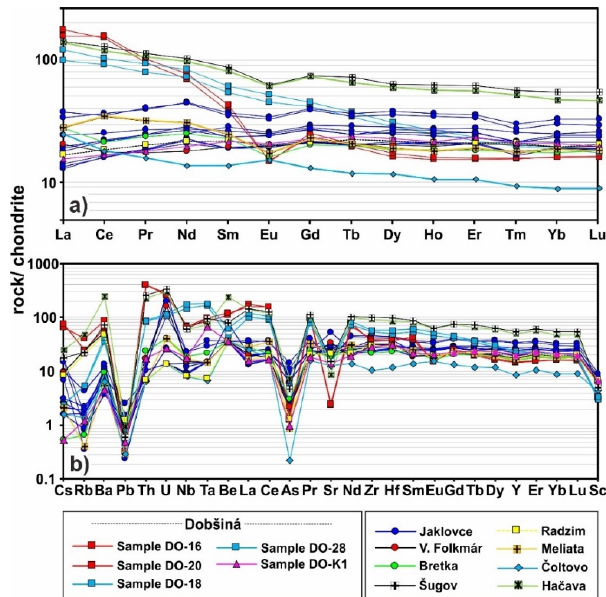
Figure 15. ( a ) Multi ‐ element diagram and ( b ) Chondrite ‐ normalized REE element patterns of metabasalts from the Meliaticum. Normalizing values are from [116].